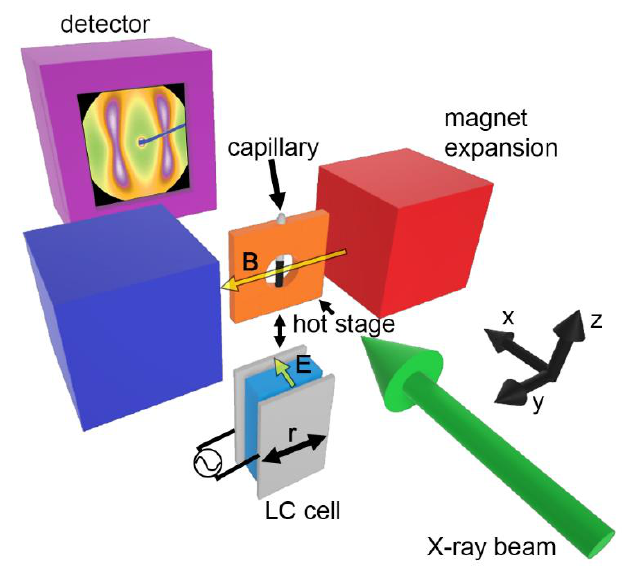
Figure 1. Experimental setup for XRD measurements on BCMs (capillary and cell samples) under a maximum magnetic field of 1 T. By using a different pair of magnet expansions, it was possible to have the magnetic field parallel to the X-ray beam. Alternatively, a superconducting magnet allowed a magnetic field up to 4 T to be applied orthogonal to the beam in the vertical direction. The hot stage allowed measurements on both capillaries and liquid crystal (LC) cells. In the latter case, an electric field could be applied across the cell, parallel to the incident X-ray